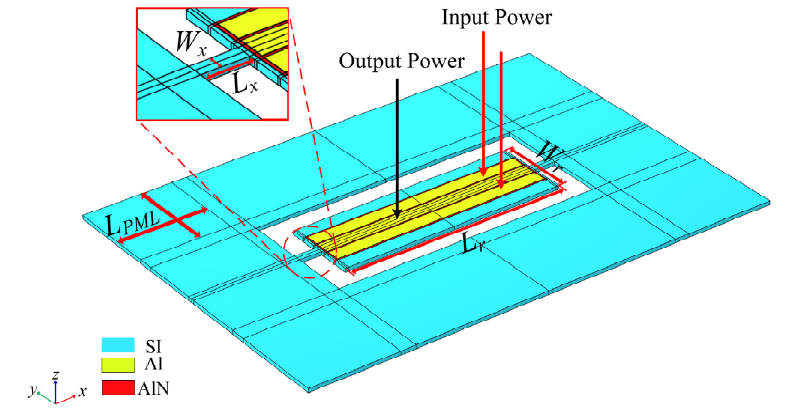
Figure 8. Simplified model of a conventional resonator for TPOS.